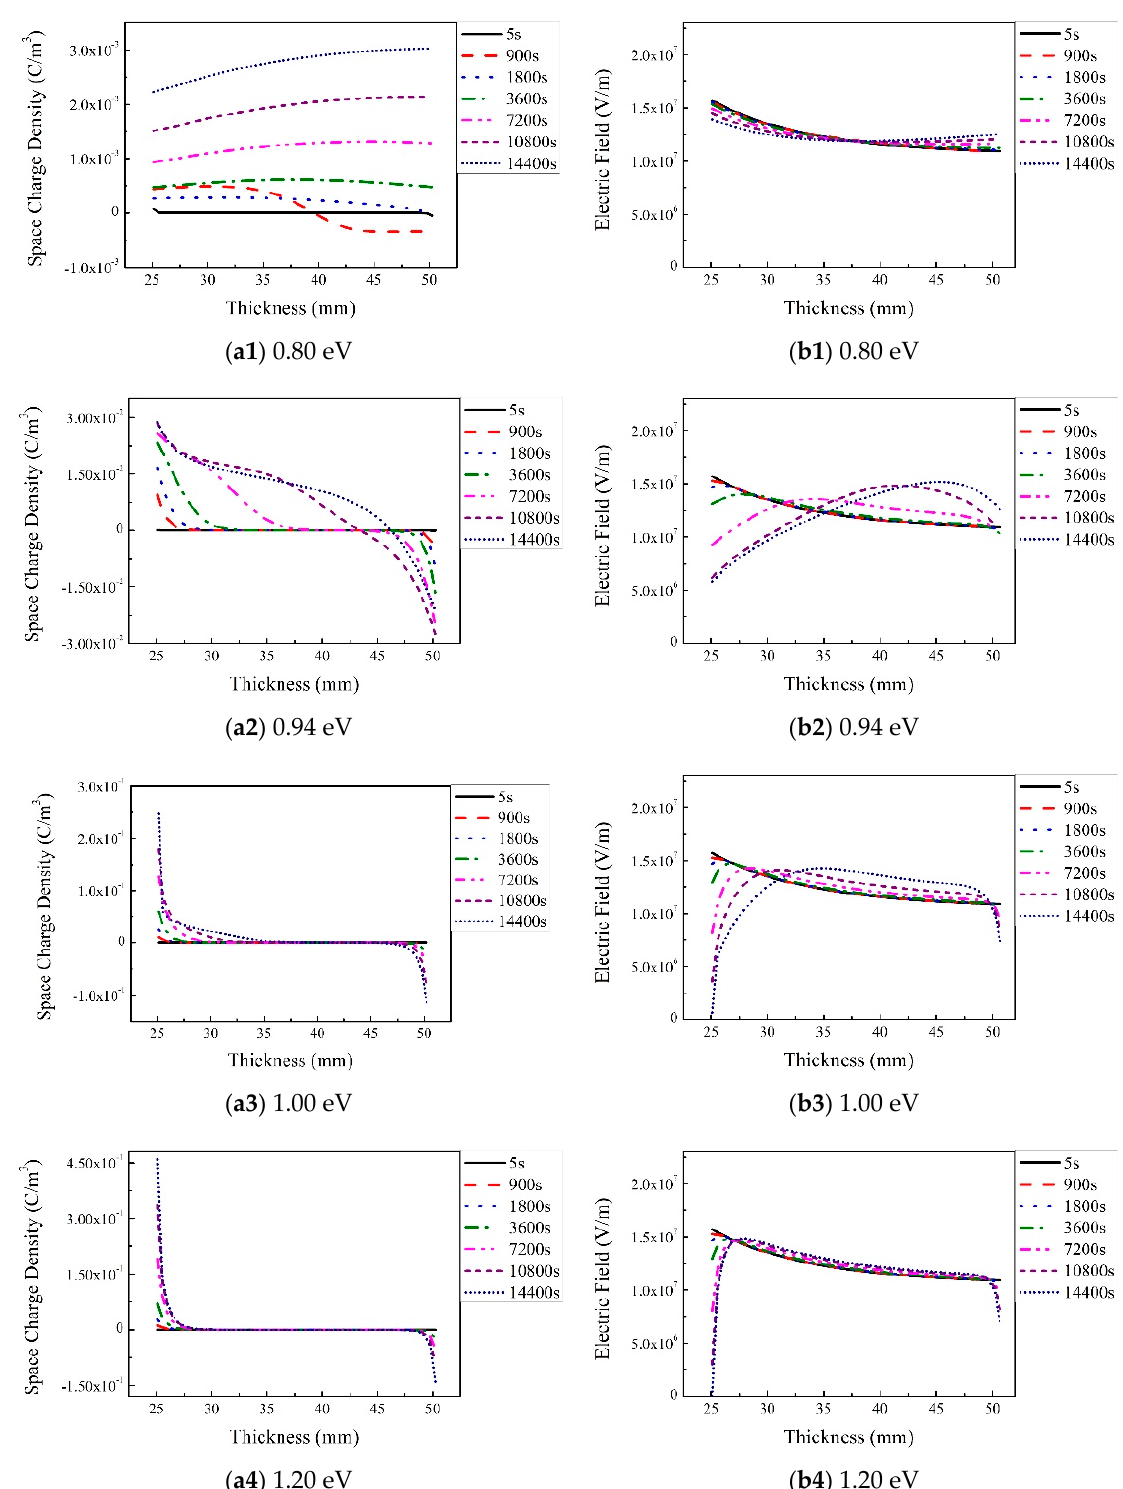
Figure 5. Simulation results of space charge distribution ( a1 - a4 ) and electric field distribution ( b1 -b 4 ) in 320 kV HVDC cable insulation when the trap depth varies from 0.8 to 1.20 eV with the trap density of 1000 × 10 19 m − 3 and load current of 1800 A.